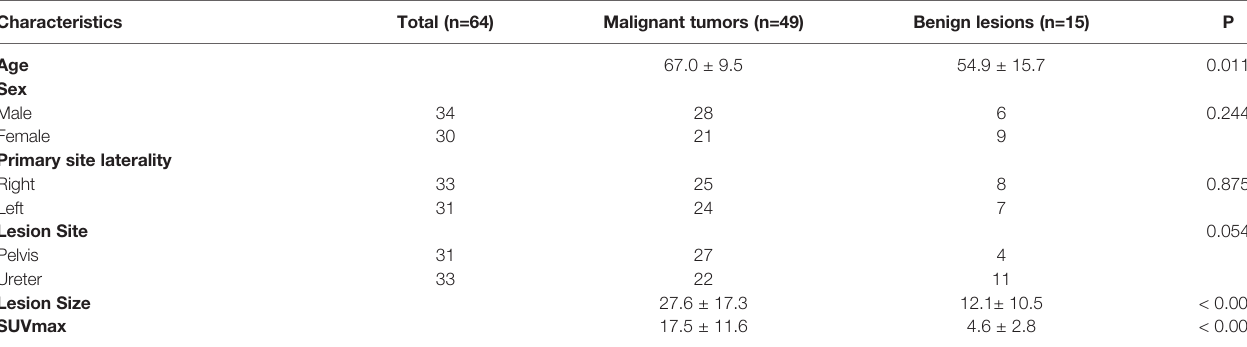
TABLE 2 | Patient characteristics according to malignant or benign upper urinary tract lesions. Characteristics